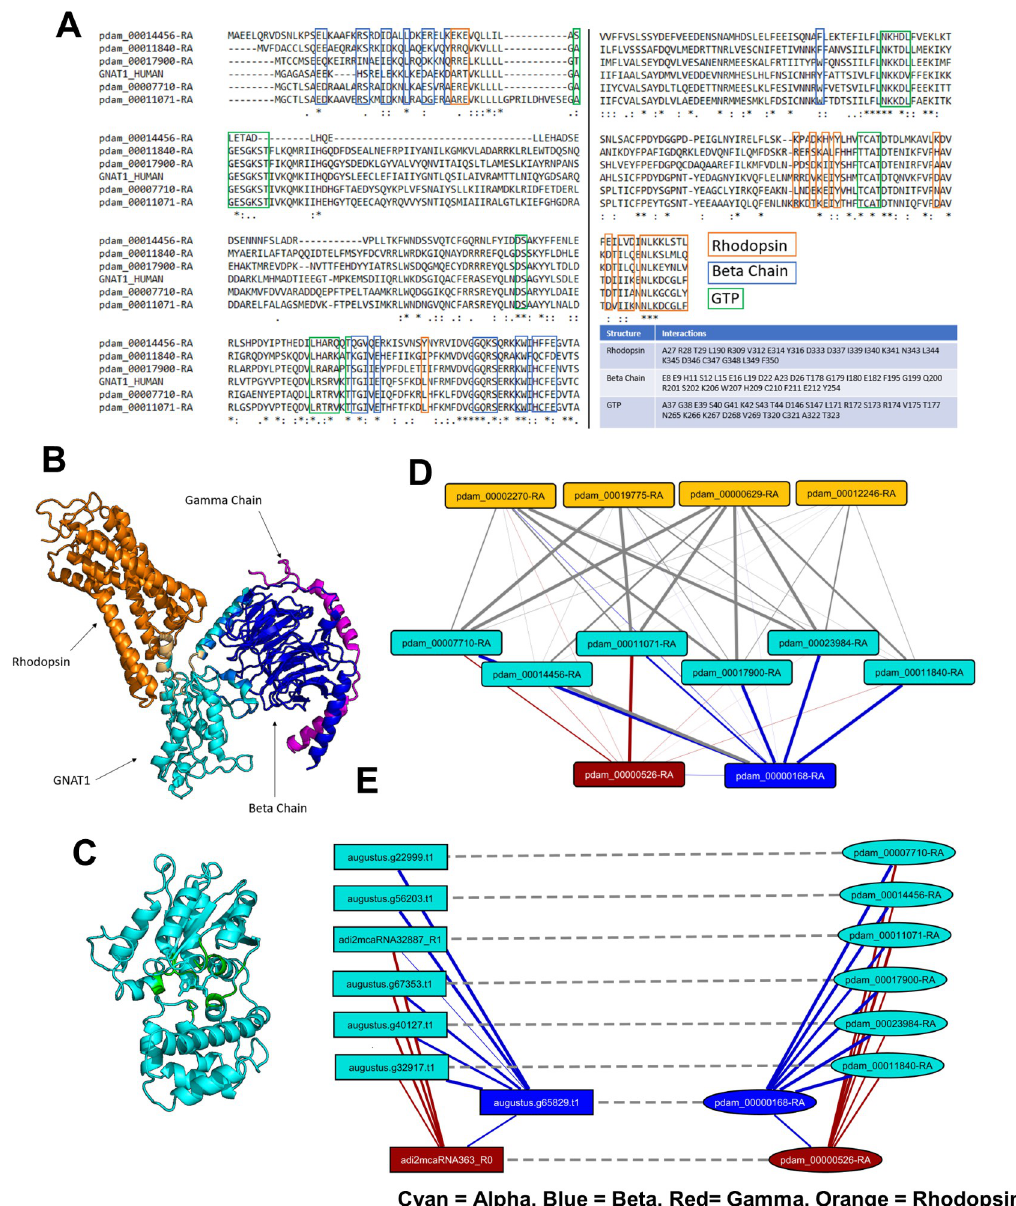
Fig 5. Identification of putative G protein subunits as candidates of immediate downstream signaling partners for GPCRs. (A) MSA of GNAT1 with coral homologues and crystal structures of GNAT1. Amino acids of GNAT1 which interact with rhodopsin, GNB1 (beta chain), and GTP are boxed in blue, red, and green, respectively. The same amino acids are also listed in the table. In the crystal structures, GNAT1 (cyan) binding interfaces with rhodopsin (orange) and the beta chain (blue) are shown in (B) and the GTP binding pocket (green) is shown in (C). (D) Predicted interactions in P . damicornis between alpha (cyan), beta (blue), gamma (orange) chains and rhodopsin (orange). (E) Predicted candidate G protein interactions in P . damicornis , and the predicted interactions of the corresponding candidates in M . capitata (solid line: Predicted interaction; dashed line: Best-bidirectional BLAST